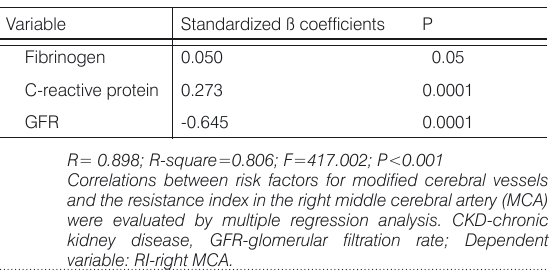
Table 6. Correlations between risk factors and the resistance indices in the middle cerebral arteries in CKD(+)